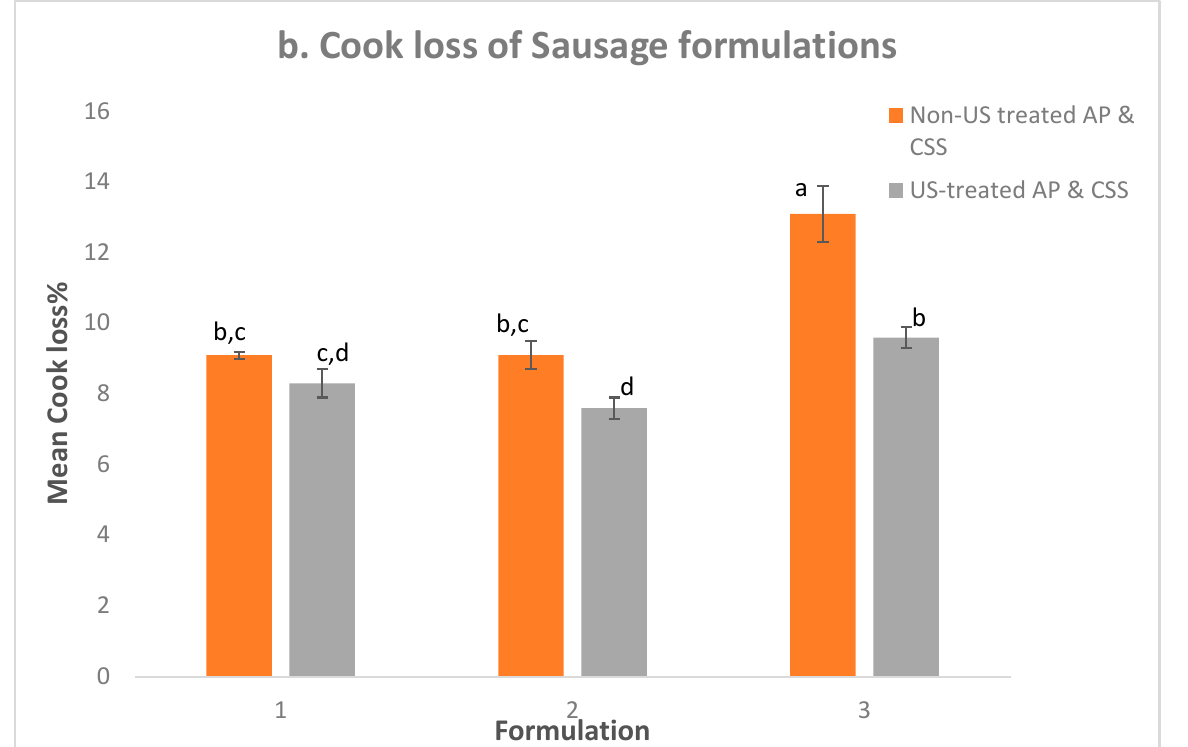
Figure 1. Bar chart comparing ( a ) WHC and ( b ) cook loss values of sausage Formulations 1, 2, and 3 containing US-treated AP and CSS with their respective formulations containing non-US treated AP and CSS. US = ultrasound treatment; AP = apple pomace; and CSS = coffee silver skin. a–e: Mean values with different superscripts within a chart are statistically different ( p < 0.05).